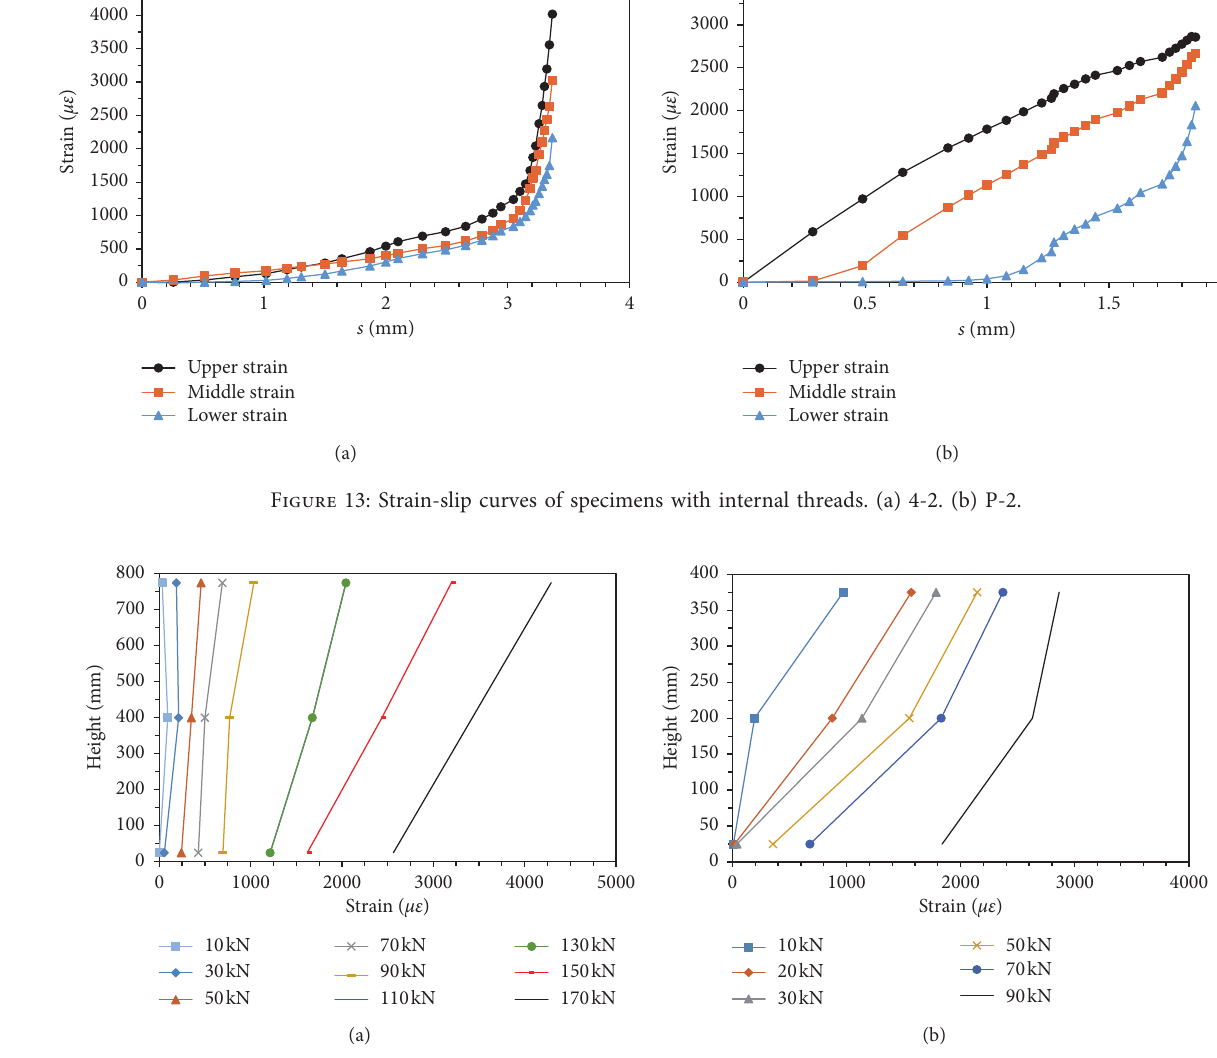
Figure 14: Strain height of FRP tube curves of specimens with internal threads. (a) 4-2. (b) P-2.